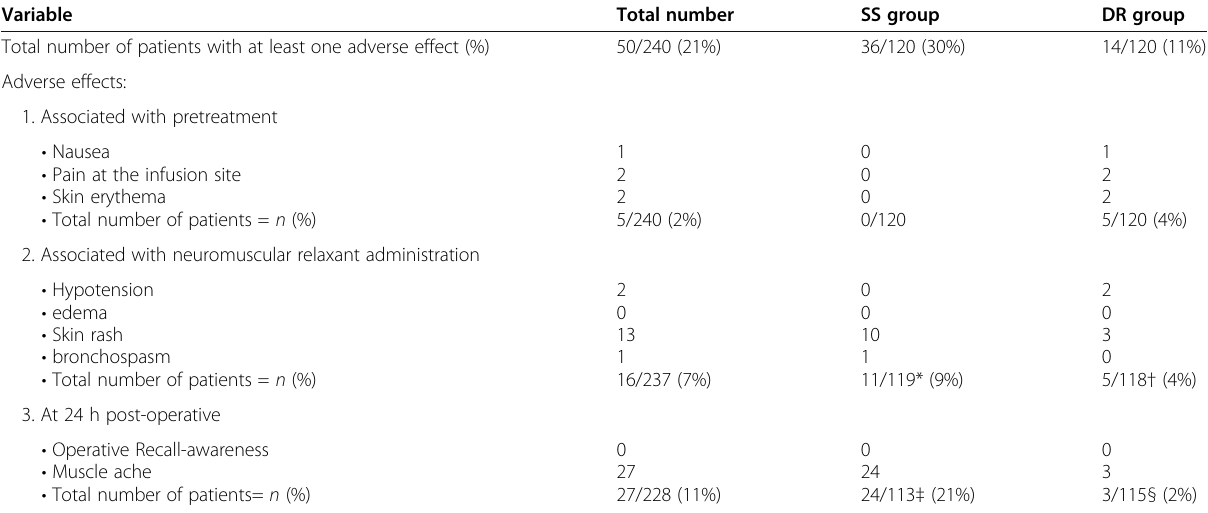
Table 5 Adverse effects between studied groups